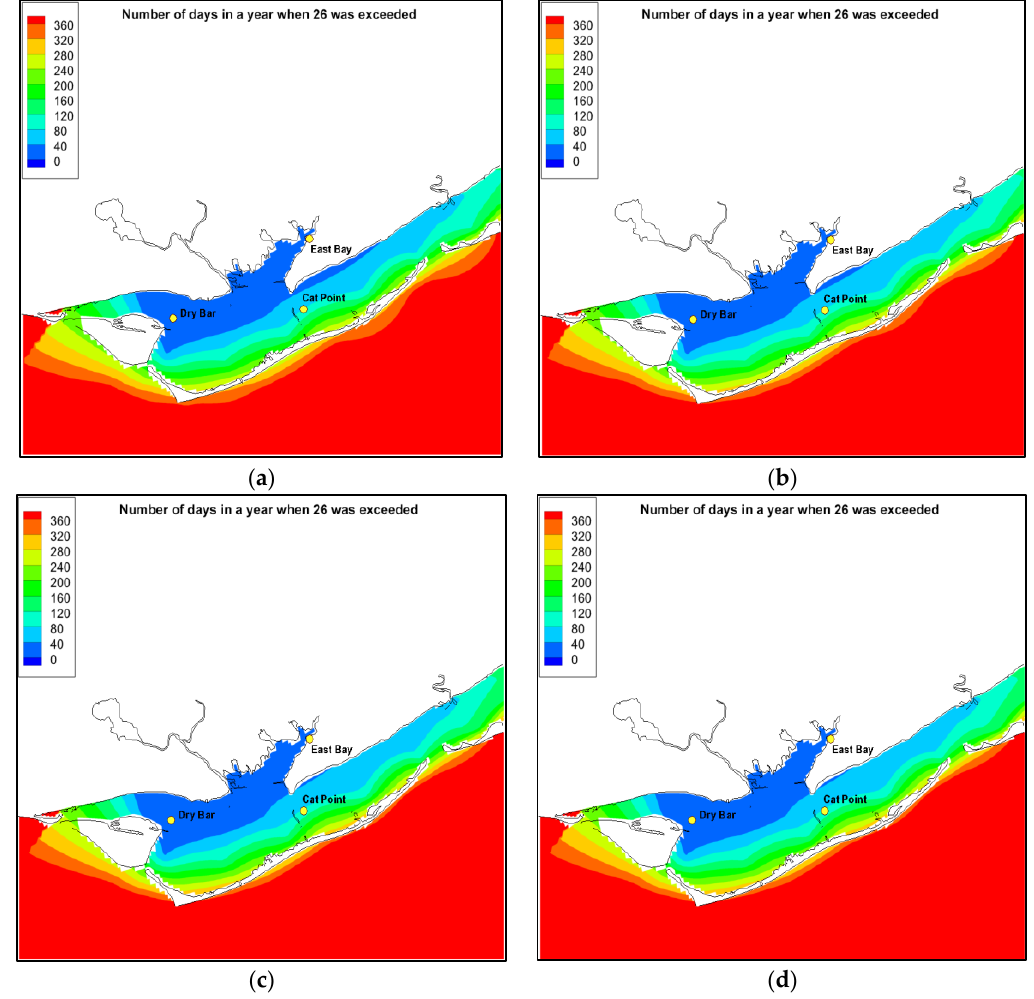
Figure 10. Average (over 1999–2008) number of days in a year when salinity exceeded 26 ppt. ( a – d )— Scenarios I–IV,